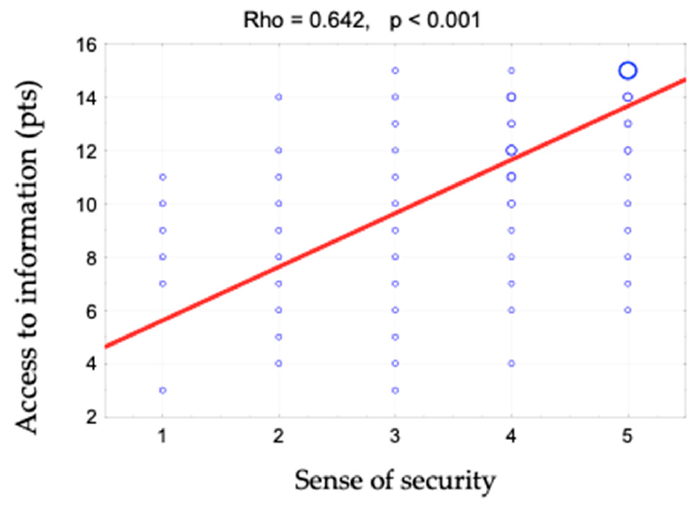
Figure 2. Correlation diagram between the sense of security (1—definitely not, 2—rather not, 3— partially, 4—rather yes, 5—definitely yes) and access to information and the value of Spearman’s rank correlation coefficient (rho).